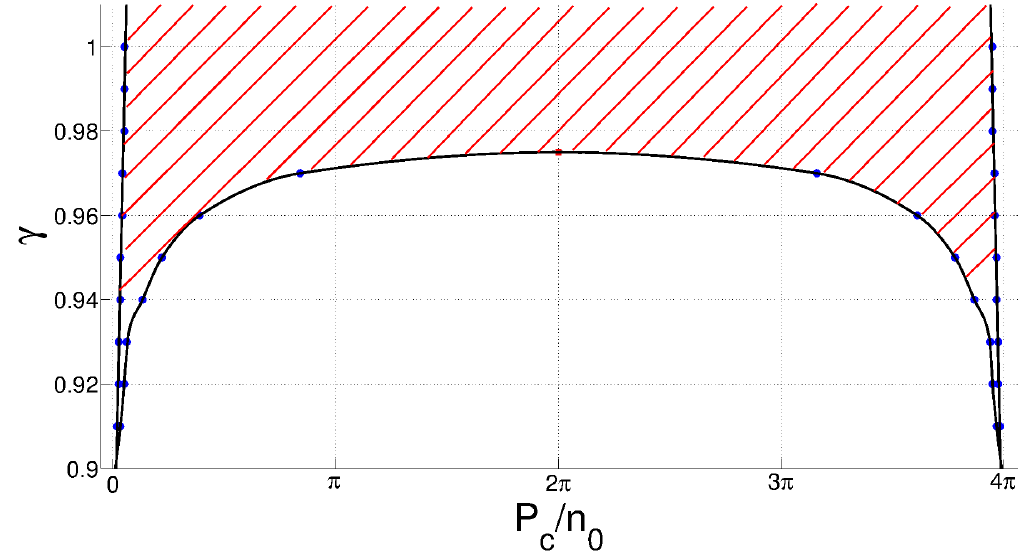
Figure 10: Stability diagram for dark (grey) solitons at ν = 0.005. Dark solitons are unstable in the shaded region. The boundary points are calculated analytically (red square, see Ap- pendix A.1) and numerically (blue dots) and the black line is a guide to the eye (spline fit to the data points). In the stable region below the black line unstable staggered solitons coexist with dark solitons. In the stability region at small and large P all excitation branches have c merged and only stable grey solitons exist.